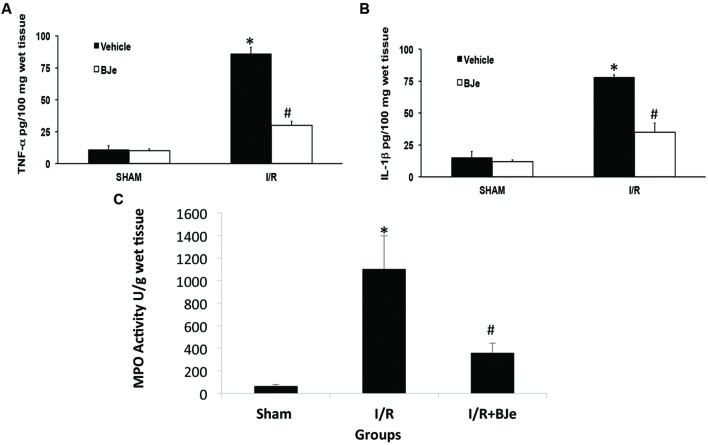
Effect of BJe on cytokine release and neutrophil infiltration. TNF-α and Il-1β ileum levels were significantly elevated after 1 h of reperfusion in I/R subjected mice (A,B) compared to sham mice (A,B). BJe reduced TNF-α and IL-1β levels (A,B). In addition, neutrophil infiltration was measured by MPO assay. Increased MPO activity was found in I/R subjected mice compared to sham animals (C). BJe treatment was able to decrease MPO activity in a significant way (C). Data are means ± SEM of 10 mice for each group. ∗P < 0.05 vs. SHAM; #P < 0.05 vs. I/R.